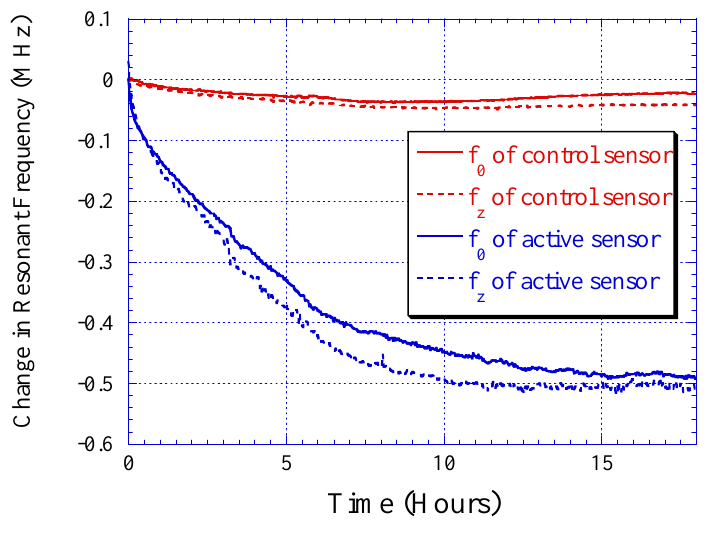
Figure 9. Change in f and f when the active sensor was embedded inside an opened 0 z Kellogg’s Frosted Flakes cereal, while the control sensor was within a sealed cereal package of the same type.